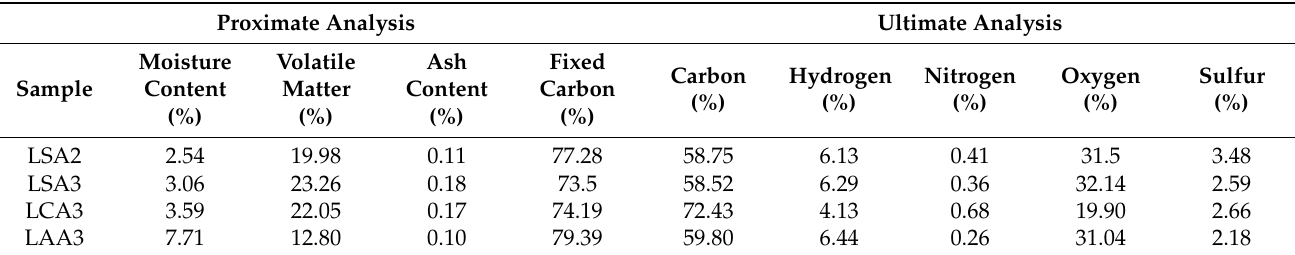
Table 1. Proximate and ultimate analysis test results of precipitated lignin.